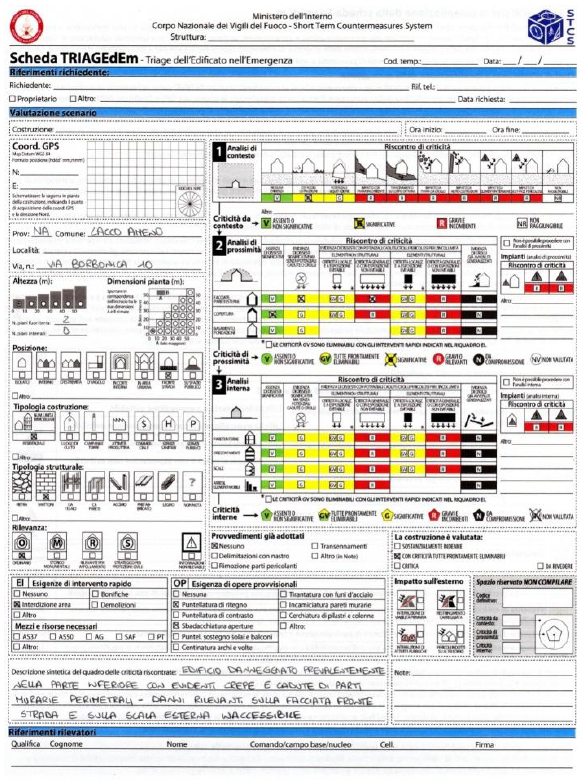
Figure 14. TriageEdEm card of a building in Lacco Ameno